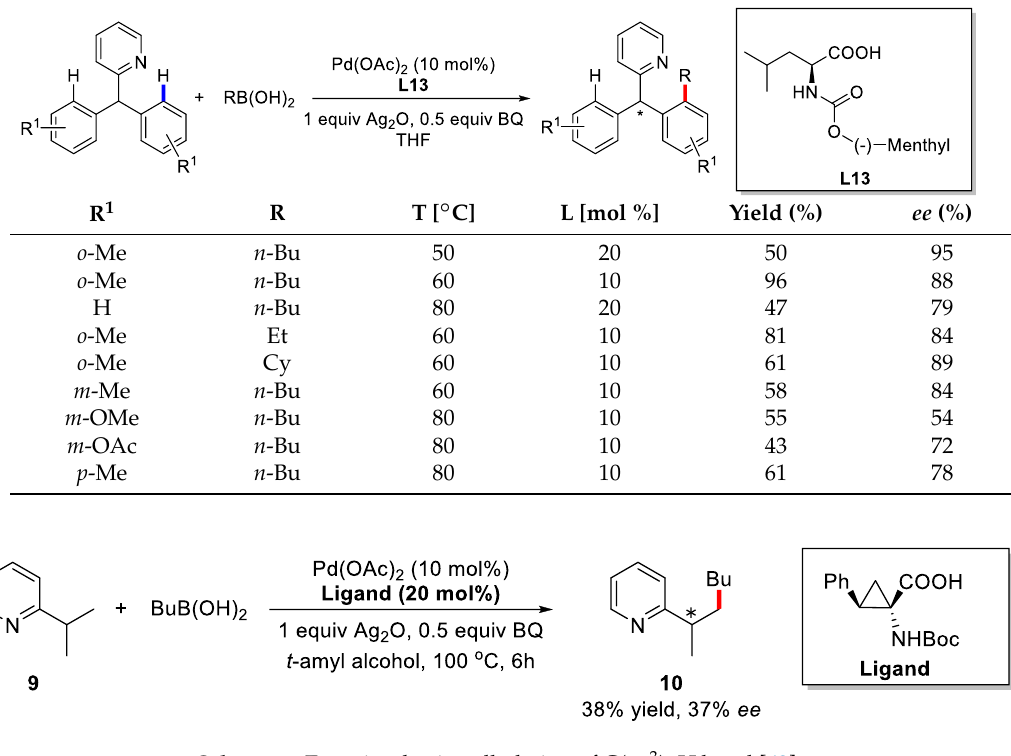
Table 1. Investigation on substrate scope [62].